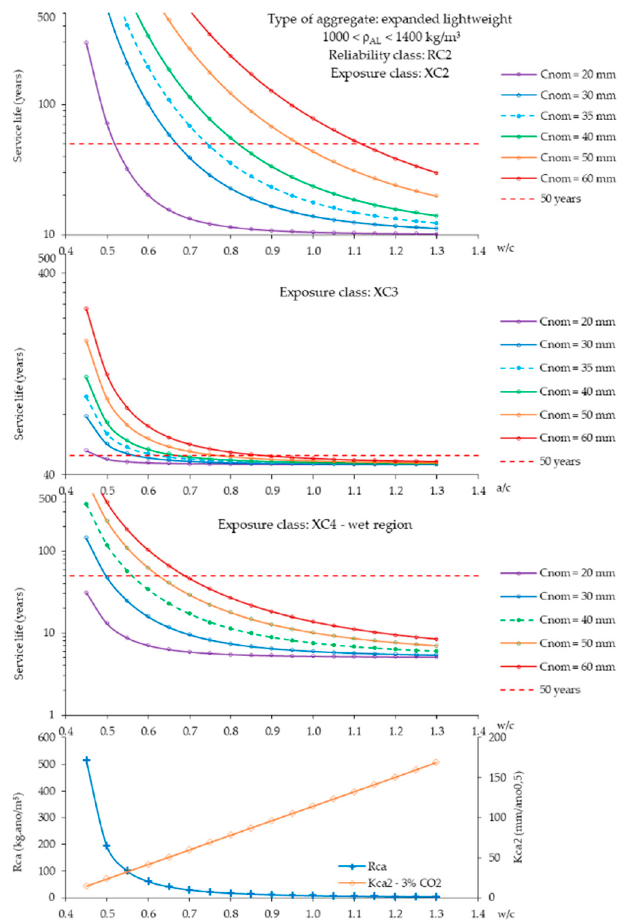
Figure 9. Example of abacuses for the service life prediction of concrete under carbonation-induced corrosion (adapted from [86]) .